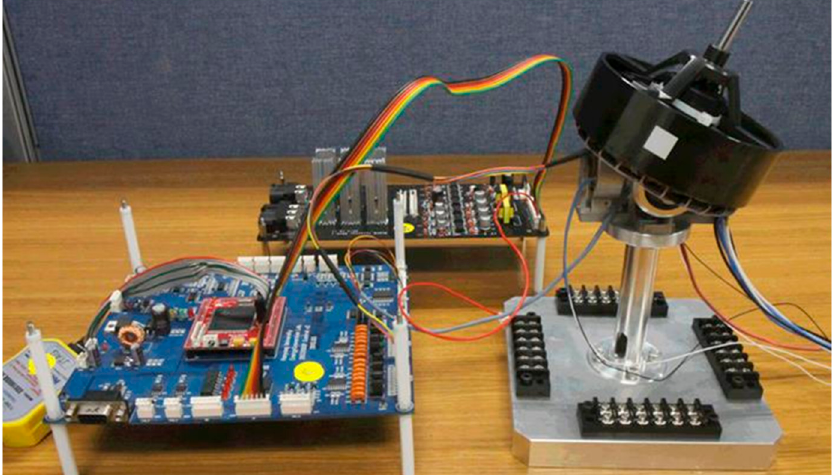
Figure 7. The experiment configuration for the position control of the HMDOF motor.